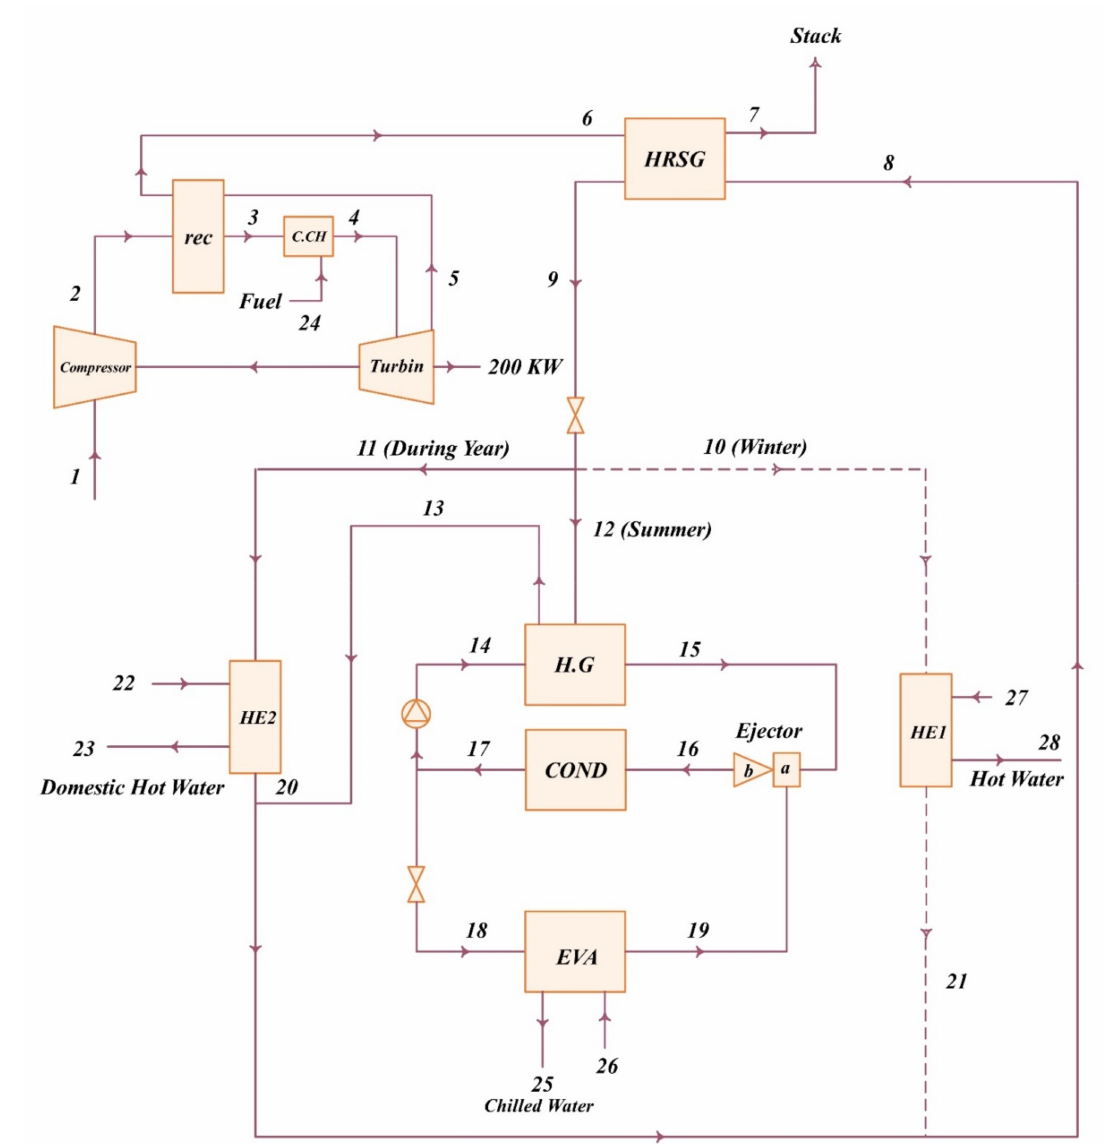
Figure 33. Schematic of the microturbine cogeneration system with the steam ejector refrigeration system